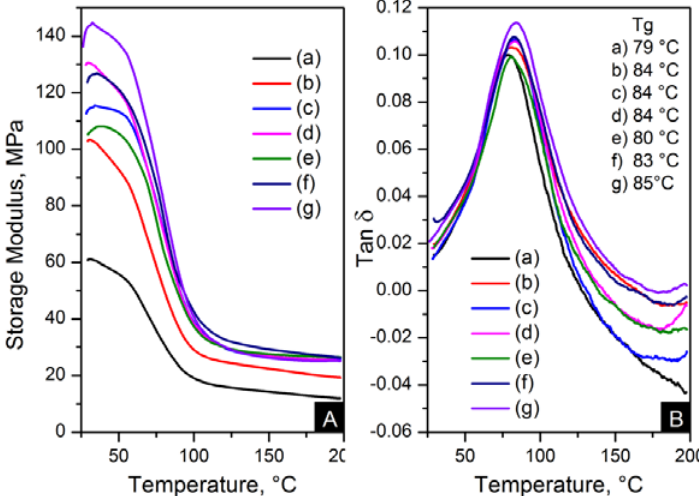
Figure 14. DMA results; ( A ) storage modulus and ( B ) Tan δ of: ( a ) pure PA66, ( b ) PA66/01RGO; ( c ) PA66/05RGO; ( d ) PA66/10RGO; ( e ) PA66/01GO; ( f ) PA66/05GO and ( g )